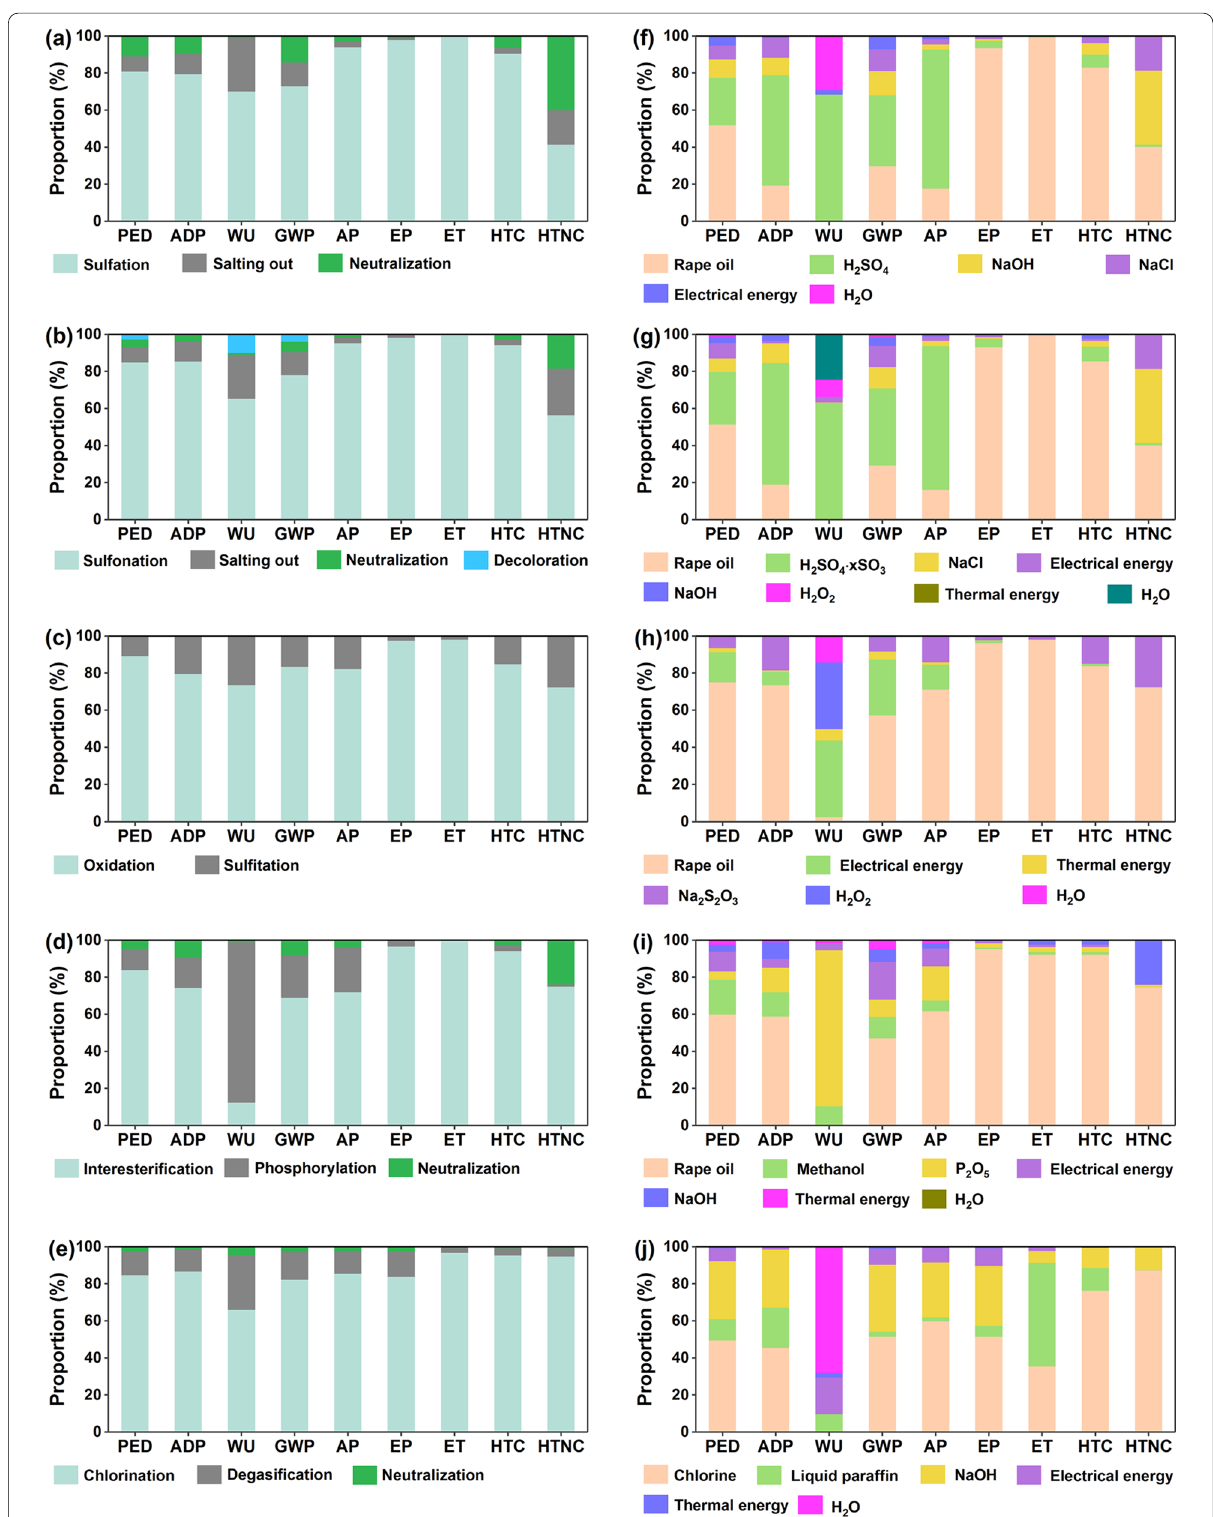
Fig. 5 Contribution of operations for SR ( a ), SNR ( b ), OSR ( c ), PR ( d ), and CP ( e ) preparation processes. Contribution of chemicals and energy for SR ( f ), SNR ( g ), OSR ( h ), PR ( i ), and CP ( j ) preparation processes (obtained from the characteristic values shown in Additional file 1: Tables